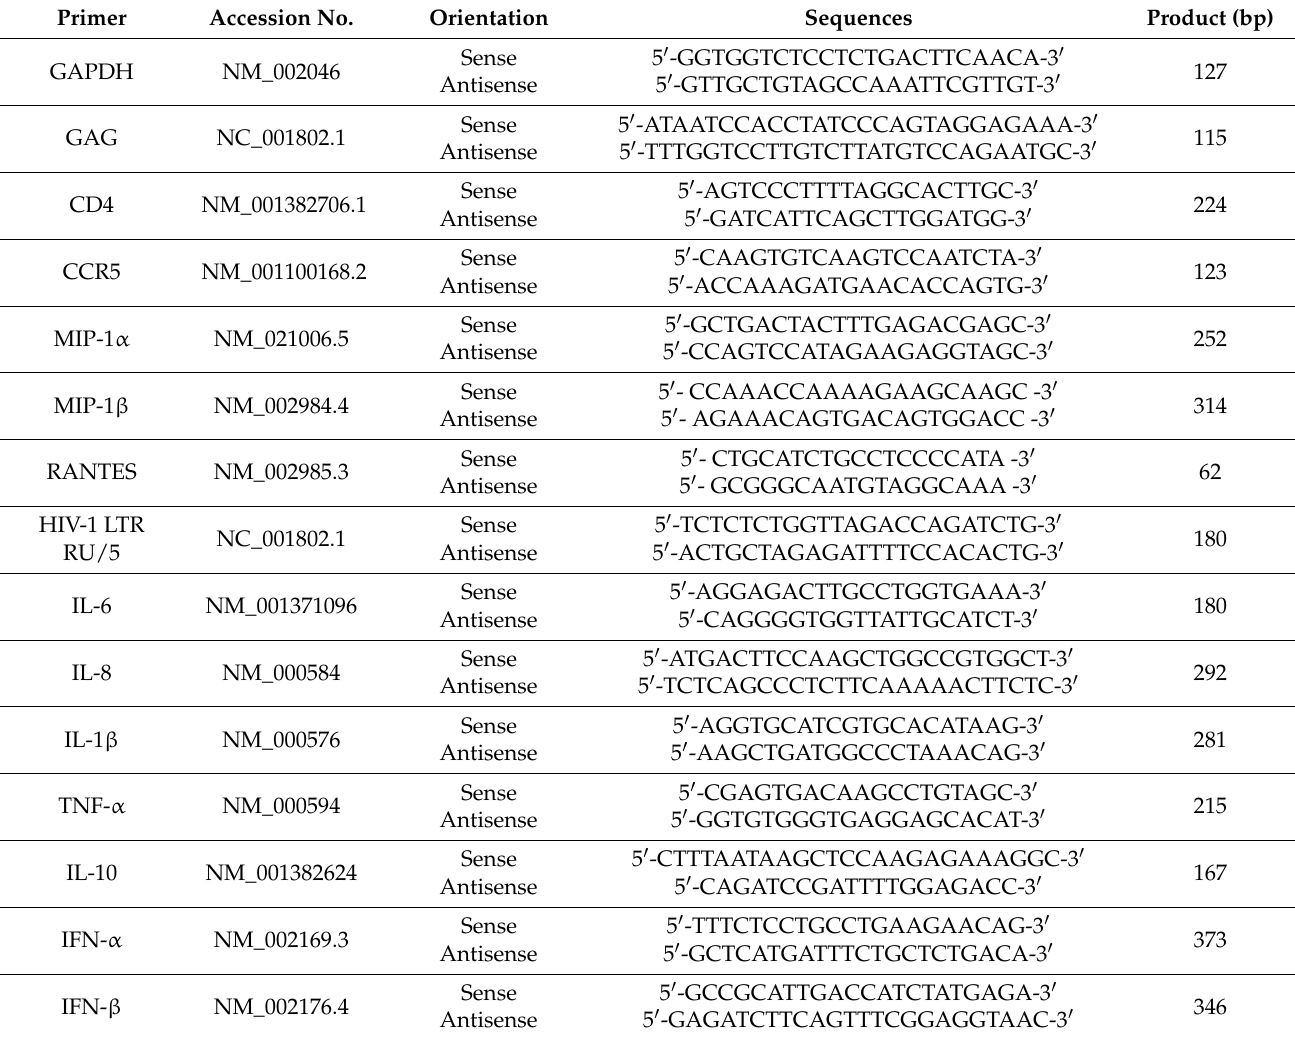
Table 1. Primer sets for real-time